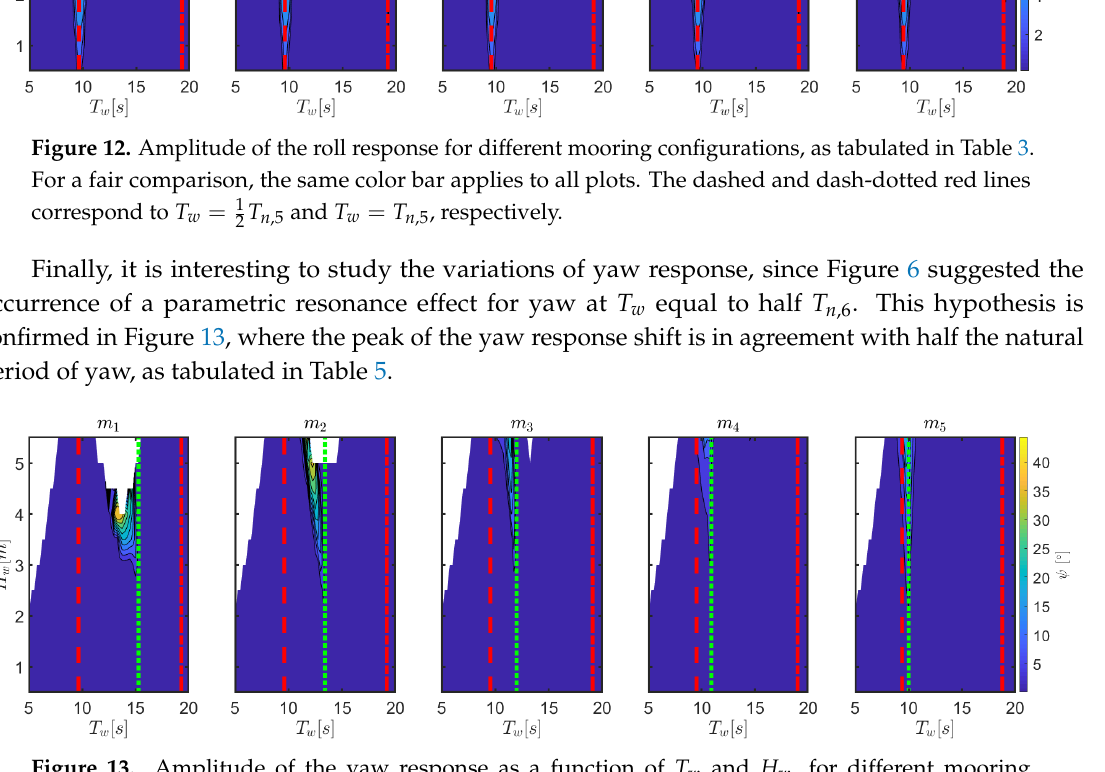
Figure 13. Amplitude of the yaw response as a function of T w and H w , for different mooring configurations, as tabulated in Table 3. For a fair comparison, the same color bar applies to all plots. The dashed and dash-dotted red lines correspond to T w = 1 T n ,5 and T w = T n ,5 , respectively. 2 The green dotted line refers to T w = 1 T n ,6 2